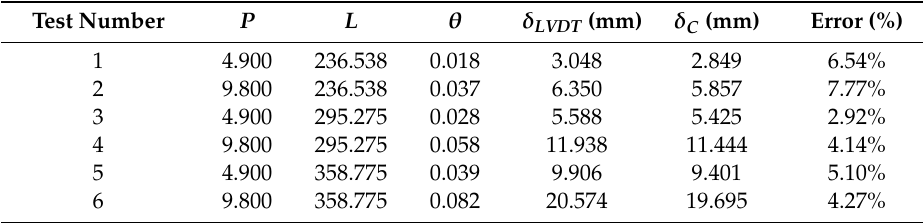
Table 5. Validation results of the exact camera movements by using a LVDT